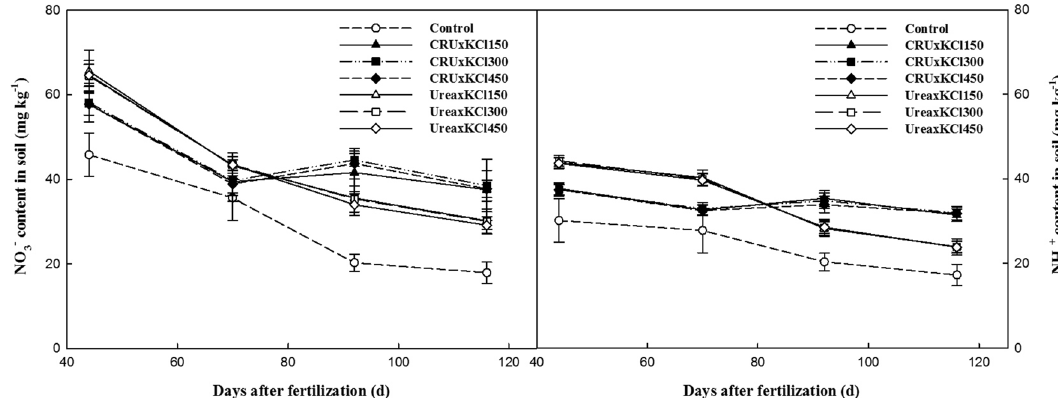
Figure 2. Changes in the soil NO 3− -N and NH 4+ -N contents.